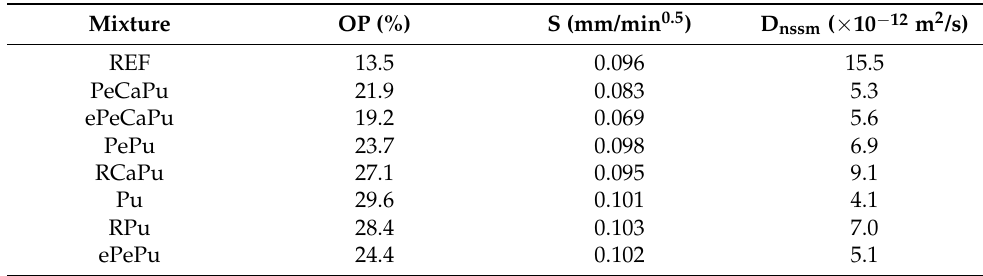
Table 5. Open porosity (OP) %, sorptivity (S), and chloride penetration coefficient (D nssm ) of concrete mixtures at the age of 28